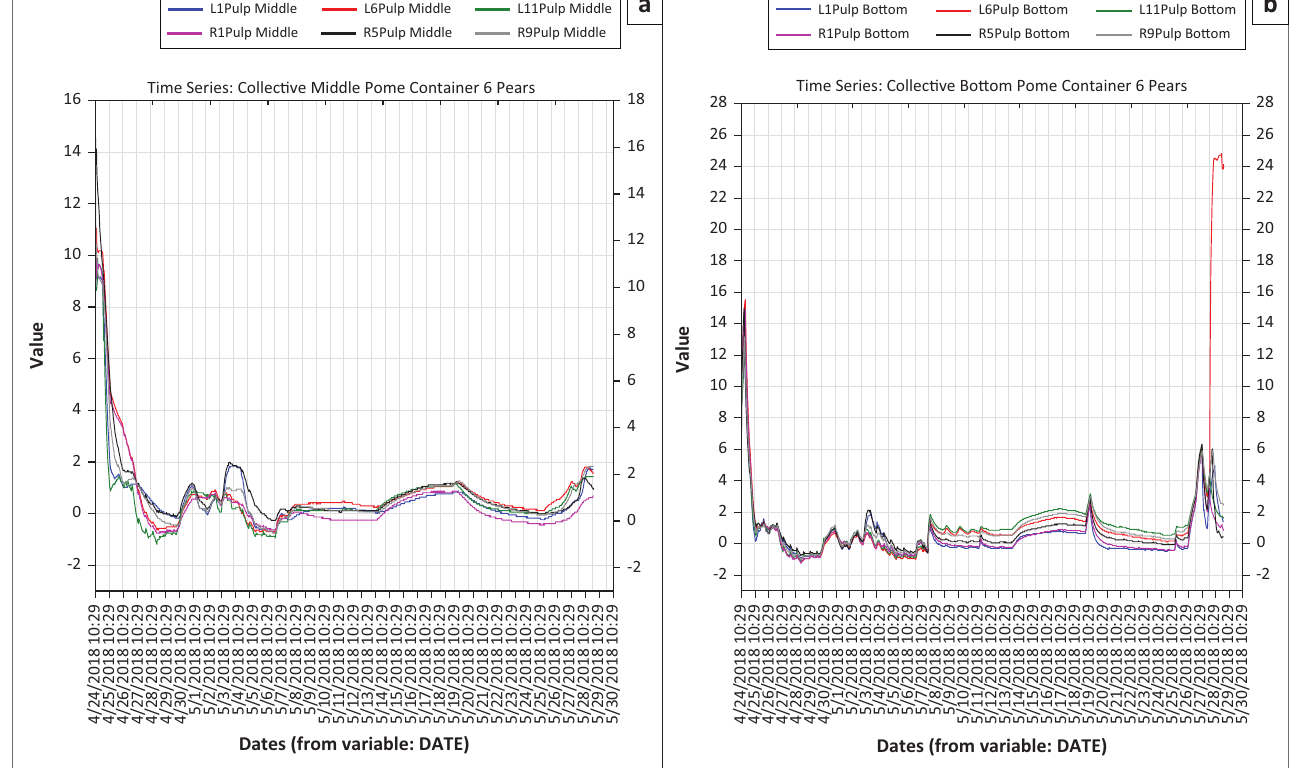
FIGURE 6: Time series line graphs (a and b) of pulp temperature profiles of pear container